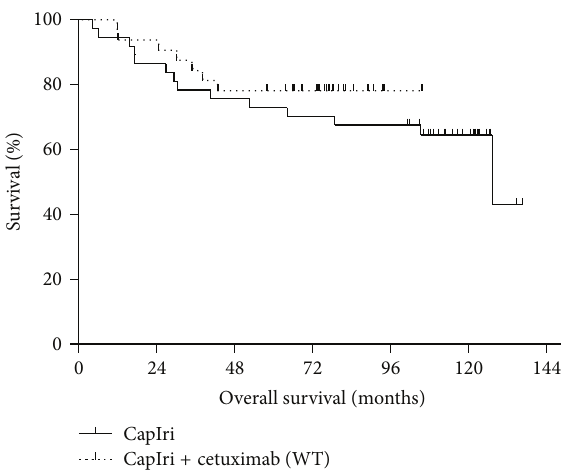
Figure 2: Overall survival of patients with locally advanced rec- tal cancer receiving capecitabine/irinotecan +/ − cetuximab based chemoradiotherapy as preoperative treatment ( 𝑛 = 86 ). Shown are survival curves of patients treated with CapIri (solid curve; 𝑛 = 37 ) versuspatientswithKRASWTreceivingCapIri+cetuximab(dotted curve; 𝑛 = 49 ), 𝑃 = 0.61 .